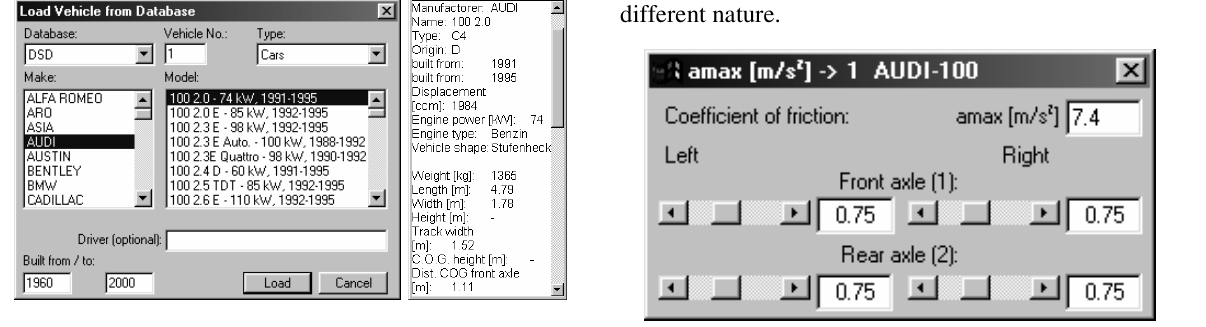
Fig 2. Selection of the model of the automobile from the database Fig 4. Introduction of the coefficient of cohesion and of deceleration depending upon the speed of movement of the automobile